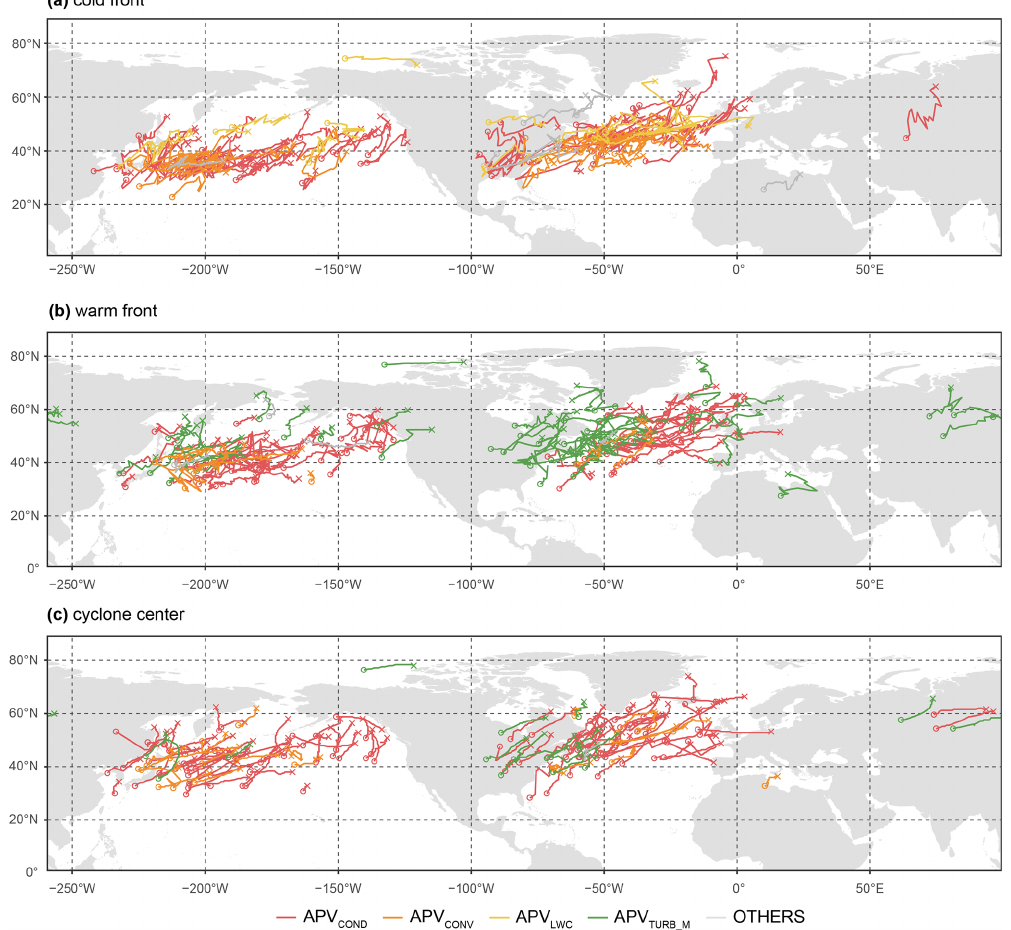
Figure 6. Geographical occurrence of (a) cold fronts, (b) warm fronts, and (c) cyclone centers for all cyclones from the cold season. Colors indicate the primary physical process responsible for the generation of positive PV anomalies along the respective feature. Open circles indicate the beginning and crosses the end of the 24h period of most rapid cyclone